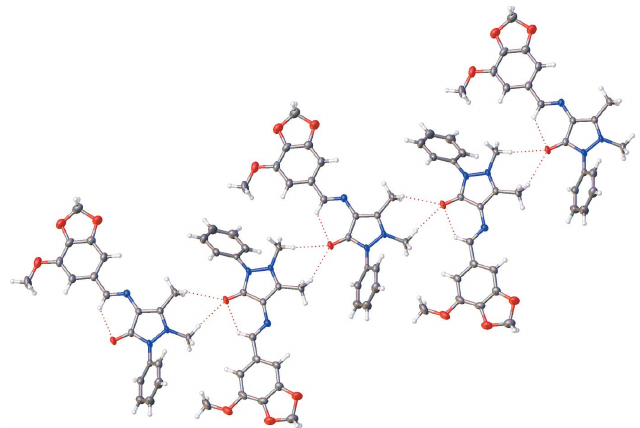
Figure 4 Detail of the structure of I showing three of the four hydrogen-bonding interactions; one intramolecular interaction and two of the three intermolecular interactions are indicated by dashed red lines.